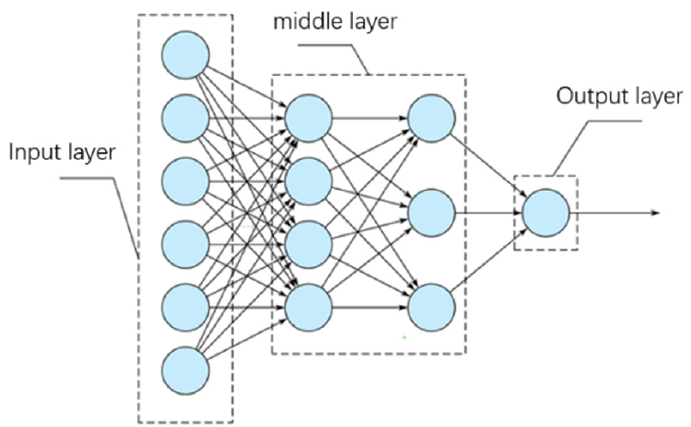
Figure 11. Schematic of DNN